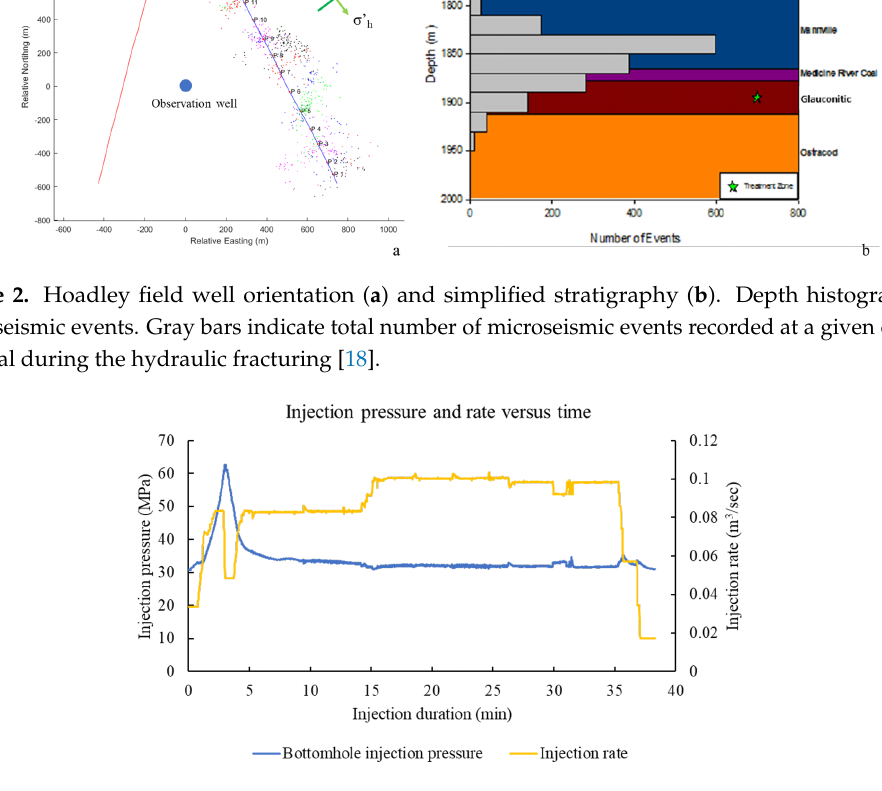
Figure 3. Field recorded injection pressure and rate for stage 12 hydraulic fracturing.